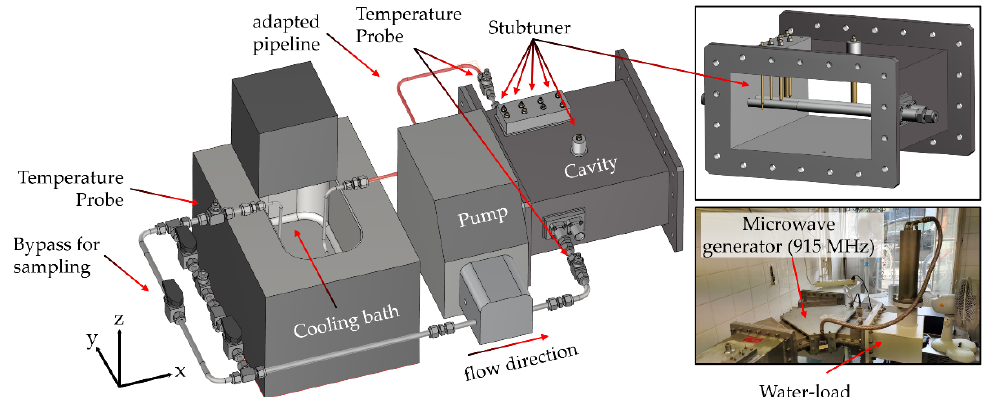
Figure 6. Closed-loop system with a 915 MHz heating unit (cavity) to heat up the cells between 39 °C and 44 °C.